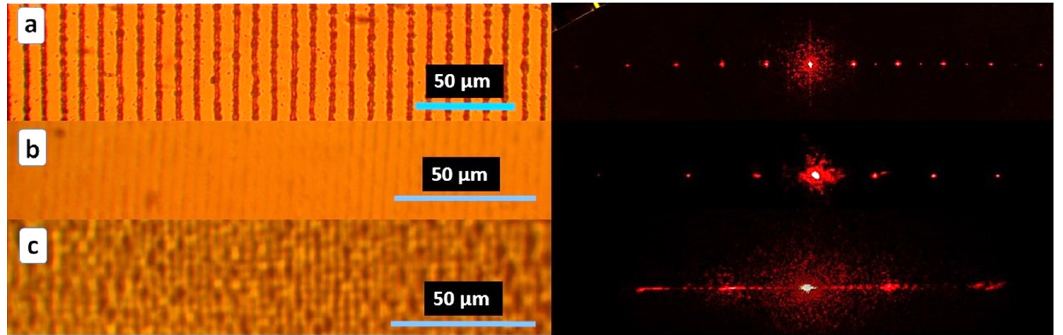
Figure 5. ( left ) Optical images of bulk diffraction microgratings in PU sample ( a – c ) and ( right ) their optical diffraction patterns for 633 nm laser light source. Thermal shrinkage by ( a ) × 1 (initial); ( b ) × 3.5 and ( c ) ×